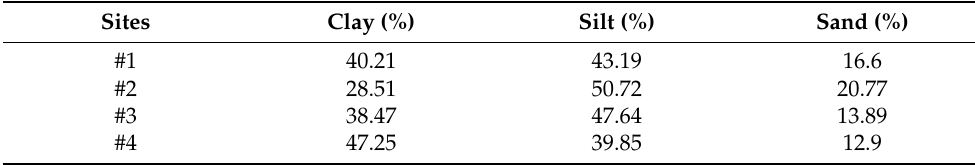
Table 1. The measured soil physical parameters for 4 sites.